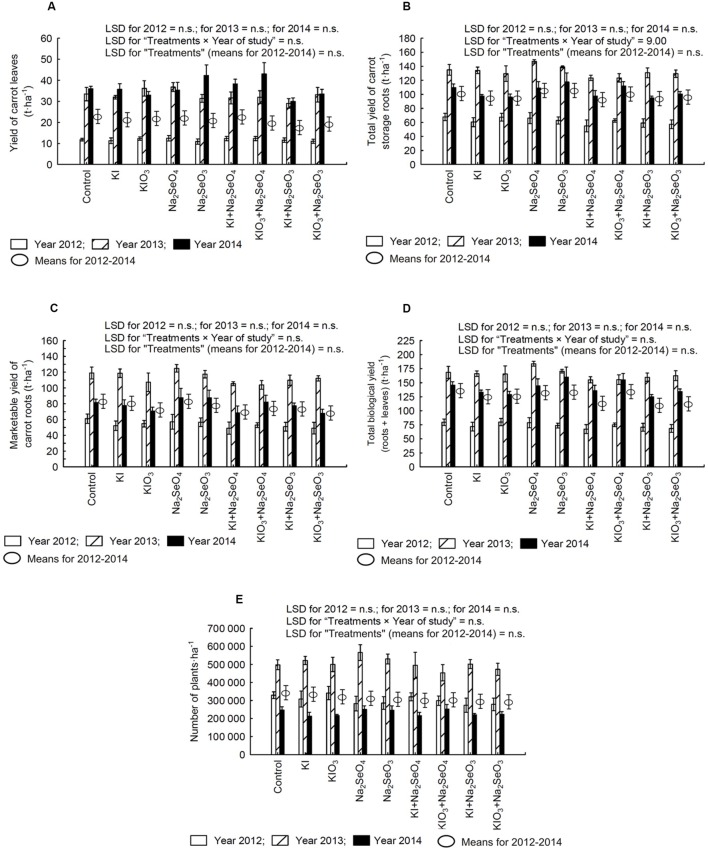
Effect of iodine and selenium fertilization on yield: of leaves (A), total (B), and marketable yield (C) of storage roots as well as the biological yield of carrot (leaves and storage roots) (D), and the number of carrot plants per hectare (E) in the years 2012–2014. LSD, least significant difference; n.s., not significant, p < 0.05. Bars indicate standard error; (n = 4).